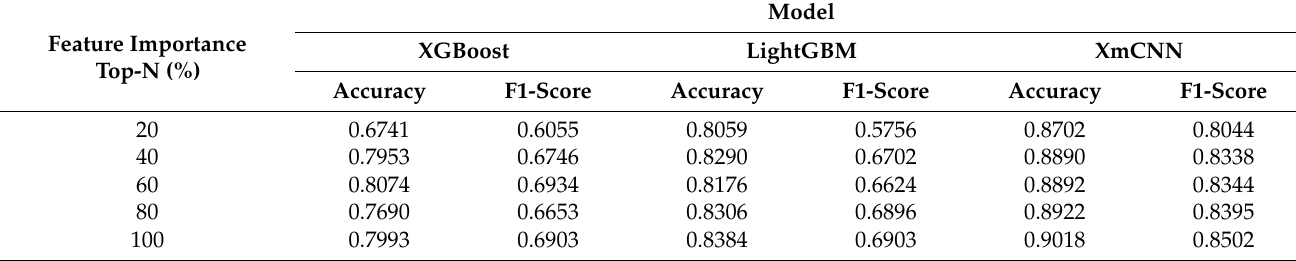
Table 11. Model performance according to feature